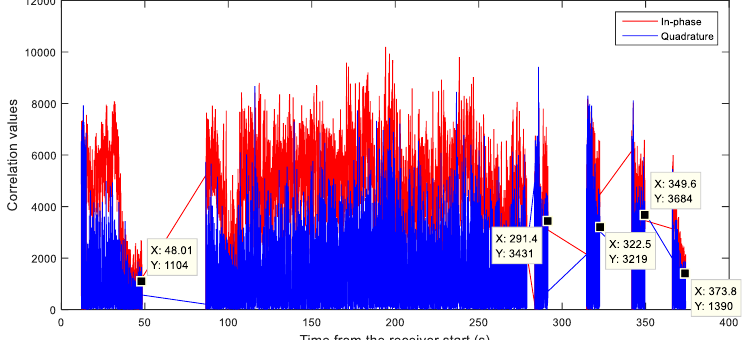
Figure 13. The tracking correlation output of SVN 71 (PRN 26).